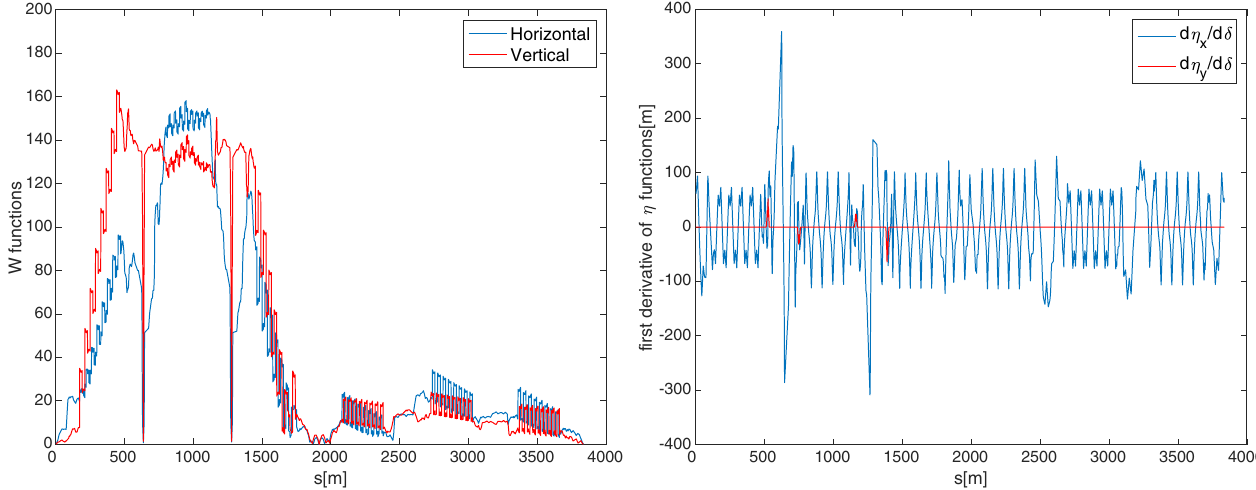
FIG. 9. The first-order chromatic optics in the electron storage ring without correction of the second-order